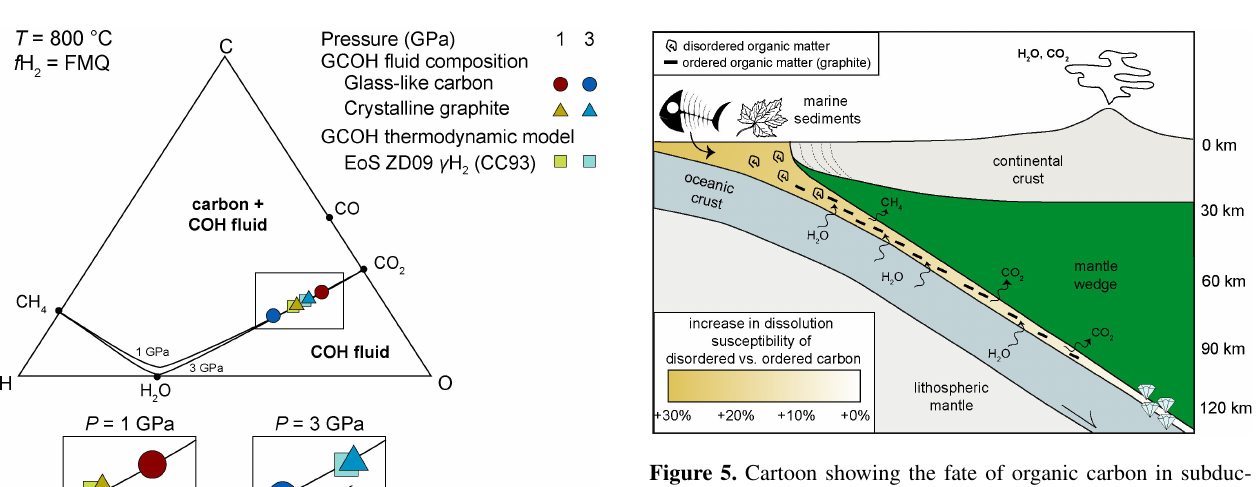
Figure 5. Cartoon showing the fate of organic carbon in subduc- tion zones modified from Tumiati et al. (2020). Ordered and disor- dered organic carbon is brought into subduction and is subject to increasing temperatures, leading to an increase in crystallinity of disordered matter. In the forearc region, at low-pressure conditions, disordered carbon is more prone to oxidation compared to ordered graphite. At these conditions, a flush of water would dissolve prefer- ably disordered organic matter from the subducted sediments, while graphite will be more refractory. As subduction proceeds this dif- ferent behavior will vanish at about 100km depth, where the free energy of graphite and disordered carbon will become